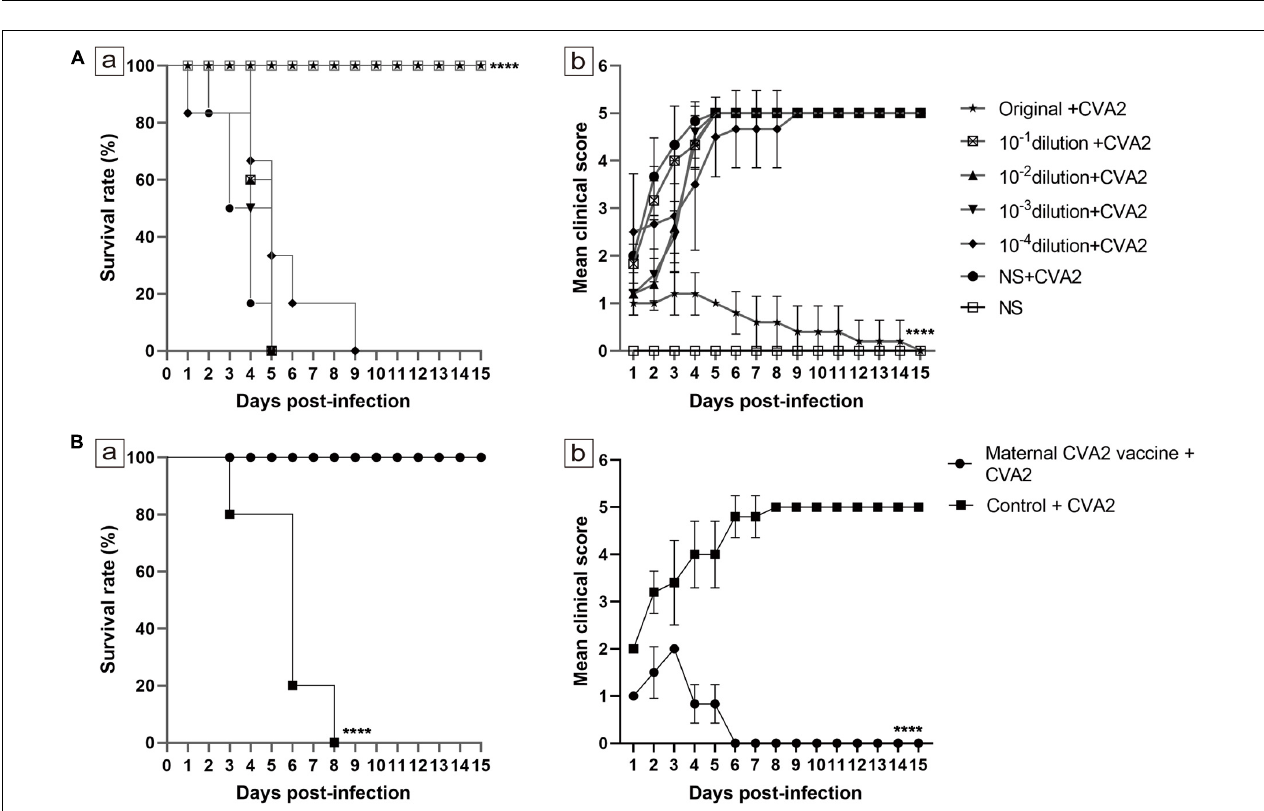
FIGURE 7 | Effects of passive immunization and maternal antibody on 5-day-old neonatal mice. (A) Effects of passive immunization. (B) Effects of maternal antibody. The survival rates (A-a,B-a) and clinical scores (A-b,B-b) were monitored and recorded daily until 15 dpi (n = 10 − 15 per group). The Mantel-Cox log rank test was used to compare the survival of the pups in each antiserum group and that of the pups in the control group at 15 dpi. **** P <